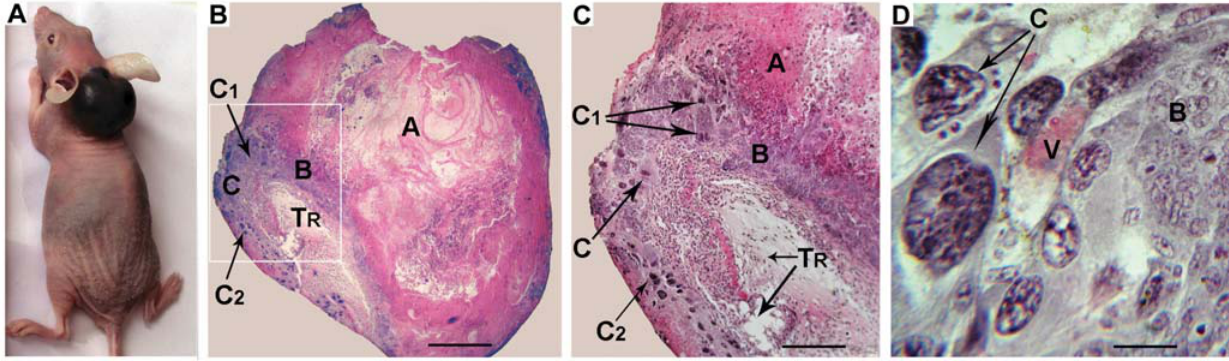
Figure 4. Tumour formation caused by subcutaneous injection of M.rossiaemeridionalis TS-like cells into a nude mouse. ( A ) External view of the tumour. ( B to D ) Histological sections of the haematoma. Staining by hematoxylin-eosin. ( B ) Cross-section through the central part of the haematoma 35 days after injection. ( C ) Magnified view of the boxed fragment of the tumour from ( B ); histological section of the haematoma across a blood vessel ( D ). (A) necrosis zone, (B) proliferating cells, (C) giant cells, (C 1 ) differentiating giant cells, (C 2 ) degenerating giant cells, (T R ) recipient tissues, (V) blood vessel. The scale bar represents 1000 m m in ( B ), 500 m m in ( C ) and 10 m m in ( D ).